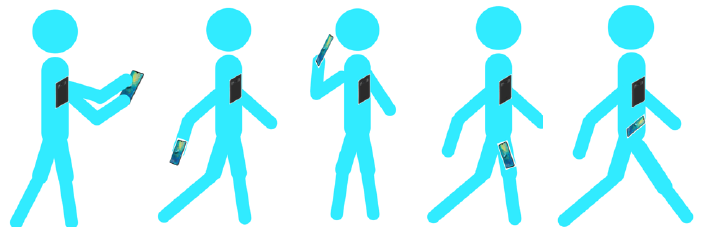
Figure 3. Diagram of the equipment of the two cell phones: Google Tango is strapped to the chest area and the IMU phone (Huawei Mate 20) is used normally, including entering text, shaking it handheld, making phone calls and placing in the pocket of